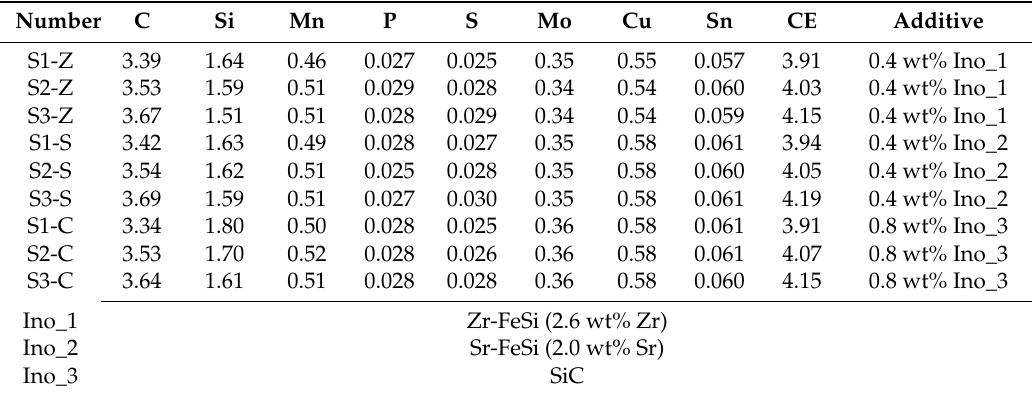
Table 1. The additives and chemical composition (wt%) of samples and